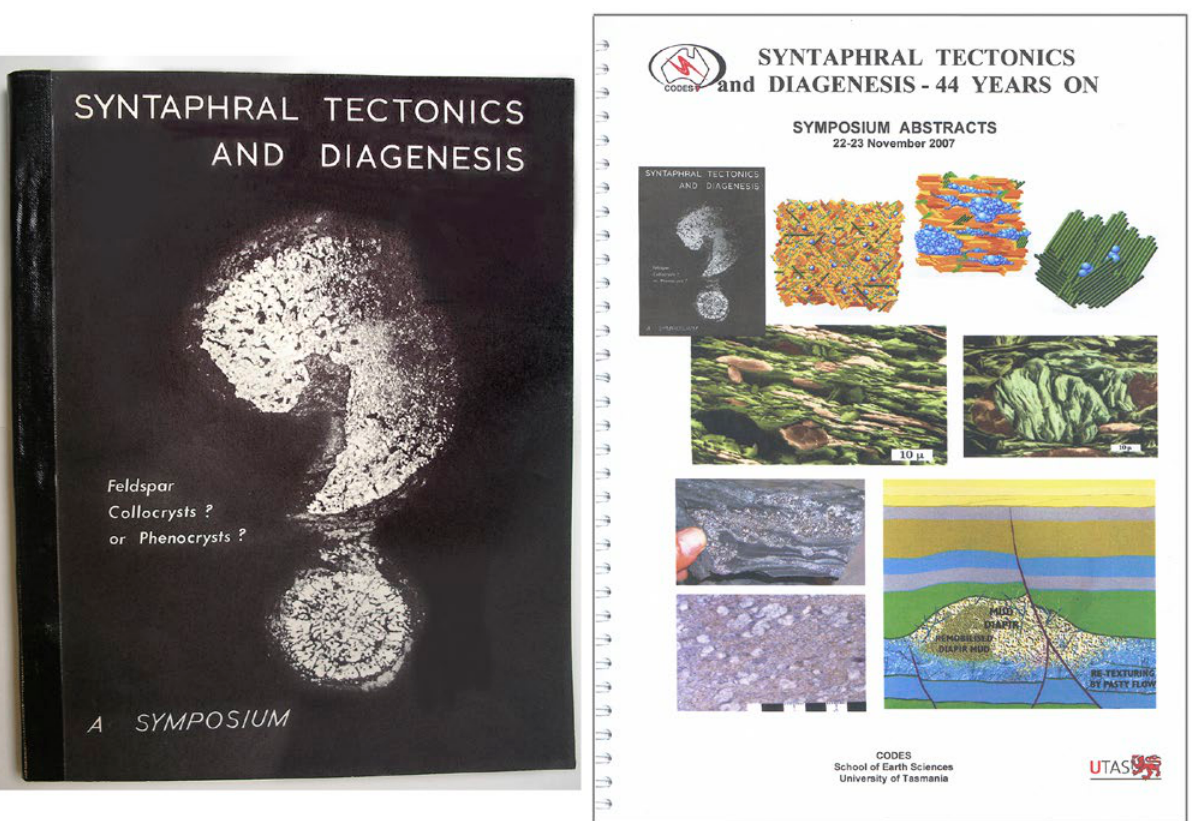
Figure 16. Records of the Symposia held at the University of Tasmania to introduce and evaluate the interdisciplinary research programs.